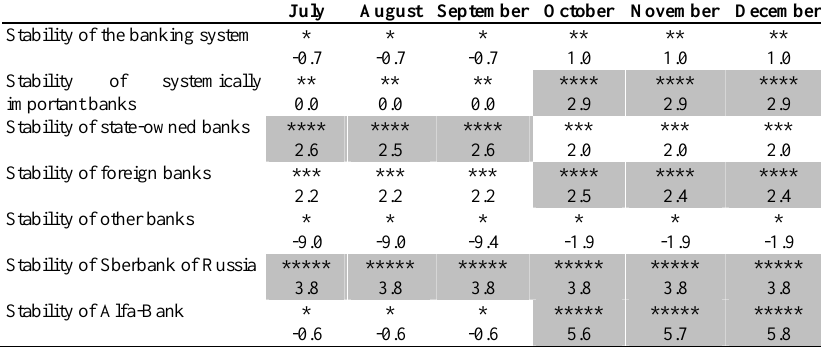
Table 10. Risk Map of Institutional Financial Stability for the second half of 2017